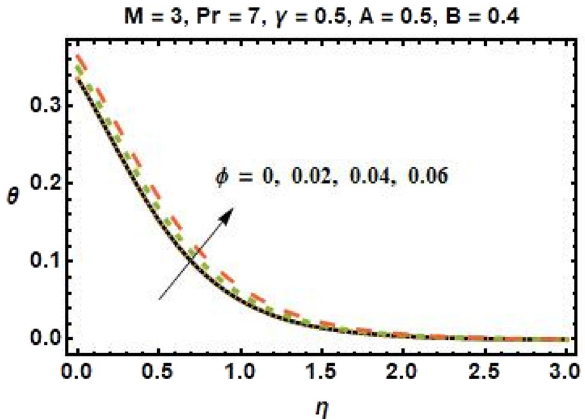
Figure 9. Temperature profiles for different values of volume fraction of nanoparticles.